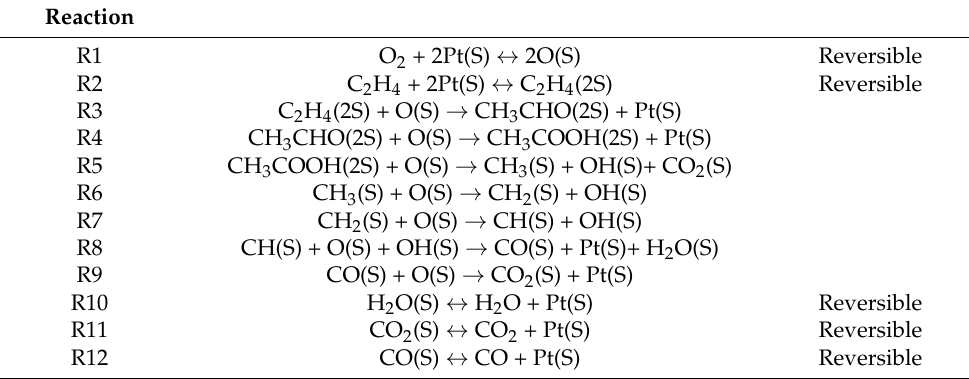
Table 2. Proposed surface reaction steps of C 2 H 4 for Pt/ γ -Al 2 O 3 .